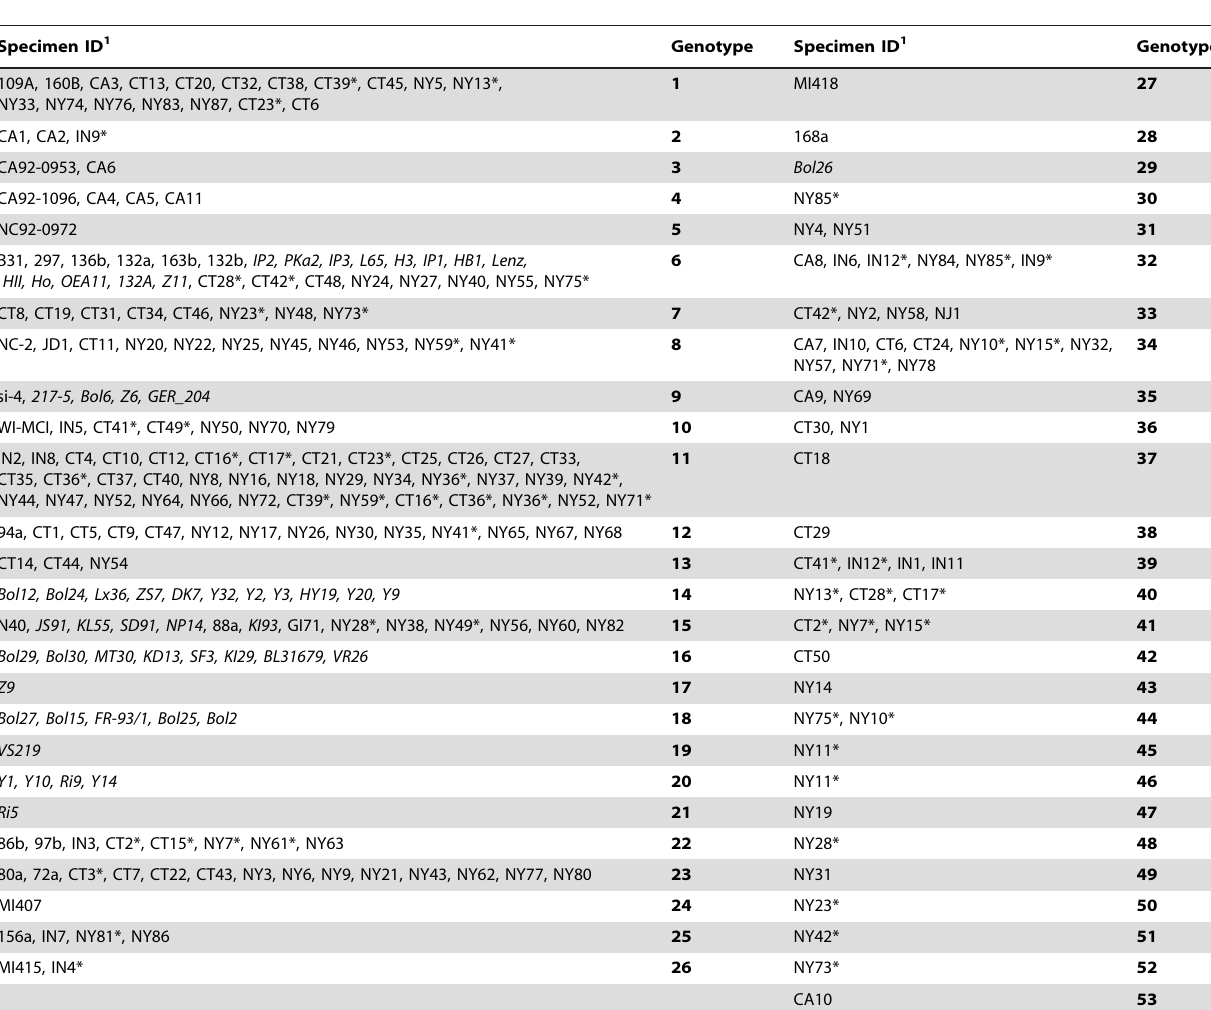
Table 3. Borrelia burgdorferi isolates and